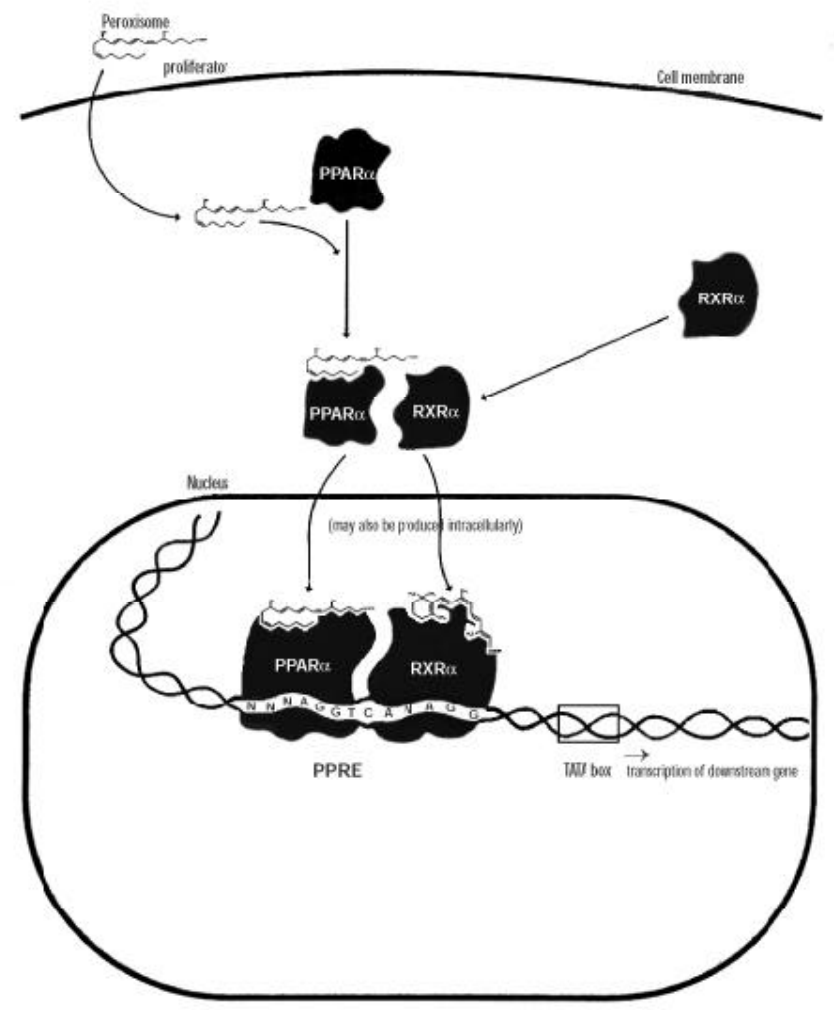
FIGURE 1. Schematic depiction of events involved in enhanced gene transcription by the heterodimers of PPAR and RXR. PPAR, peroxisome proliferator-activated receptor; RXR, retinoid X